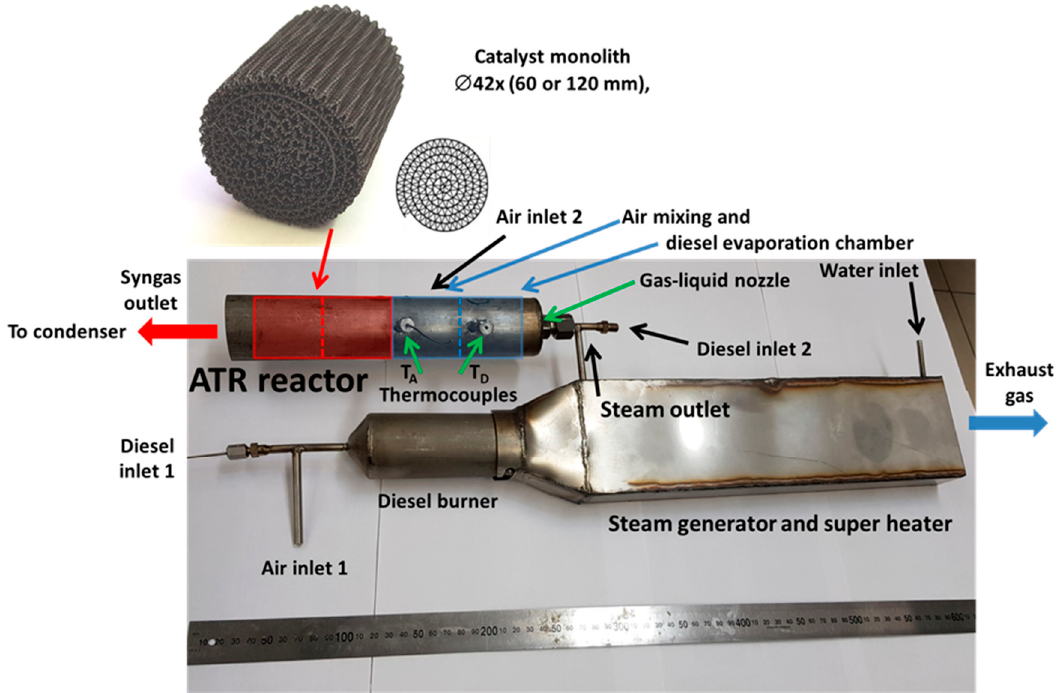
Figure 18. A general view of the ATR diesel reactor together with a starting diesel burner, an evaporator and a steam superheater [91].